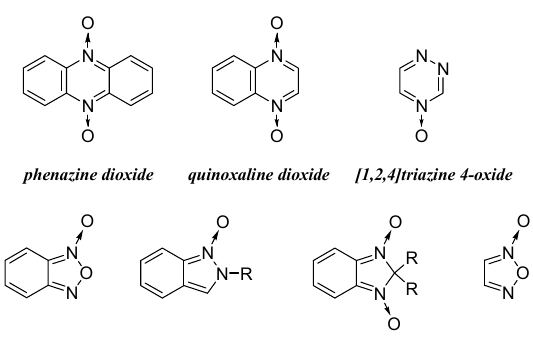
Figure 1. The N -oxide chemotypes selected for the study.